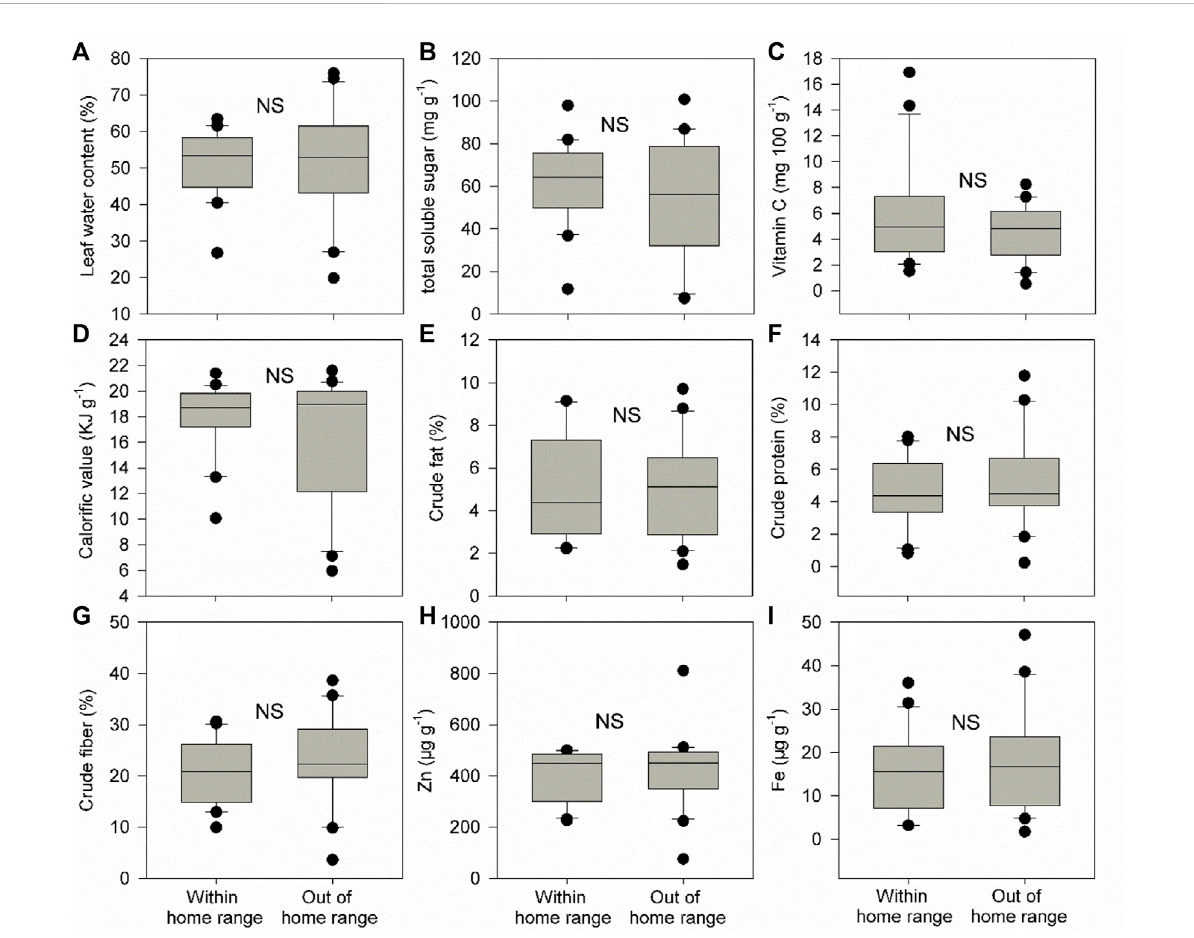
FIGURE 4 Differences in community weighted mean values (CWM) for nine food plant nutrient traits (A-I) between within and out of the home range of groupE.Theseninetraitsincludeleafwatercontent(%),totalsolublesugar(mgg − 1 ),vitaminC(mg100 g − 1 ),calori fi cvalue(KJg − 1 ),crudefat(%),crude protein (%), crude fi ber (%), Zn ( μ g g − 1 ), and Fe ( μ g g − 1 ). Box plots show the median (line within the box), 25th and 75th percentiles (the boundaries of the box), and 90th and 10th percentiles (error bars) of CWM for food plant leaf nutrient traits. NS indicates p > 0.05 and shown are results from Wilcoxon signed rank